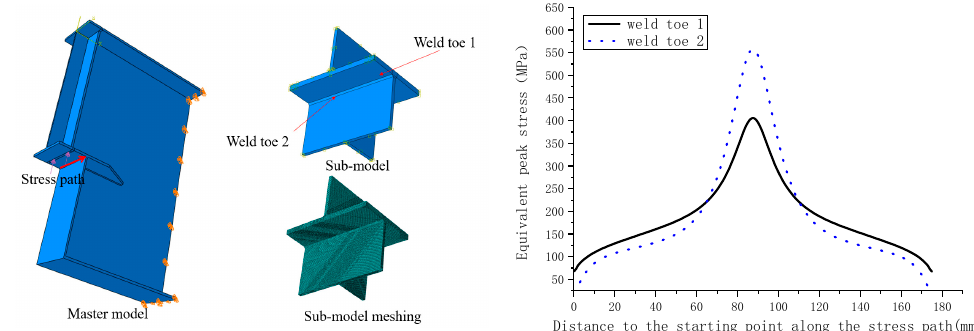
Figure 18. Peak stress analysis model and results for the variable-section supports with right-angle end plates.